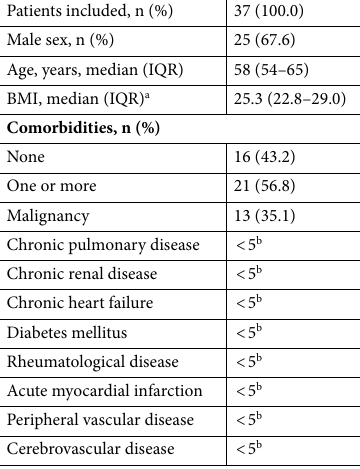
Table 1. Baseline characteristics. Baseline characteristics of patients hospitalized at the department of infectious diseases or the intensive care unit at Rigshospitalet in the time period May 4th, 2020–June 5th, 2020. a Data on BMI was missing for two patients. b Exact number of patients censored to maintain patient confidentiality due to small number of